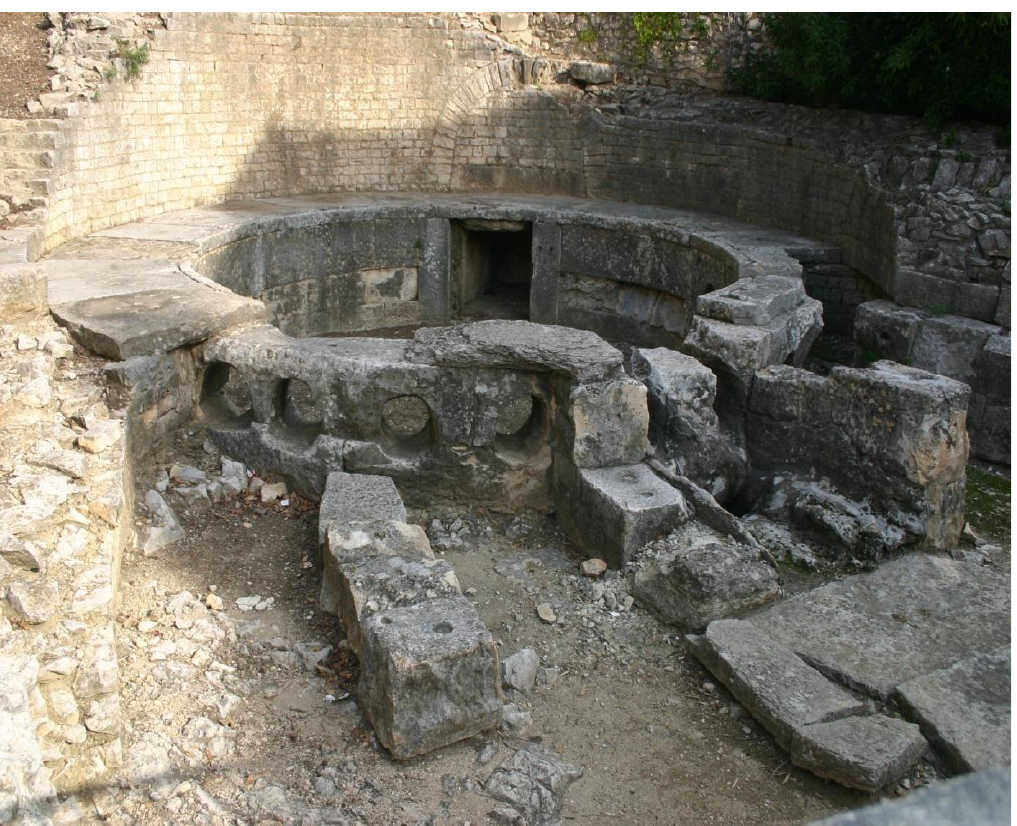
Figure 39. The Pont du Gard castellum showing the back wall rectangular water delivery port from the aqueduct and several of the castellum front wall water exit ports to pipelines leading to city destinations. Photo by author.